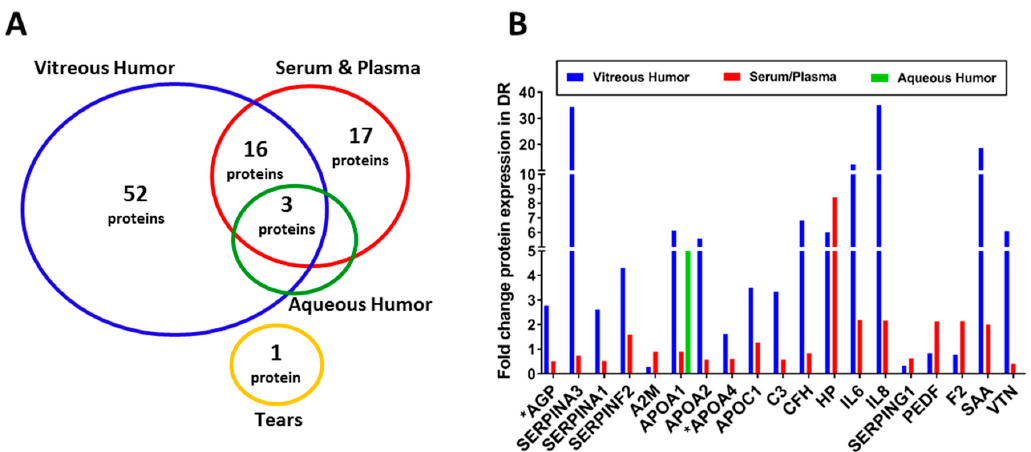
Figure 1. Summary of differentially expressed proteins identified in biofluids of DR patients . ( A ) The number of potential biomarkers of retinal inflammation in each biofluid, as identified by the studies discussed in this review. ( B ) The bar graphs represent fold change in expression of 19 biomarkers identified in at least two biofluids. * AGP and APOA4 proteins were detected in the AH of DR patients, but fold change was not available.